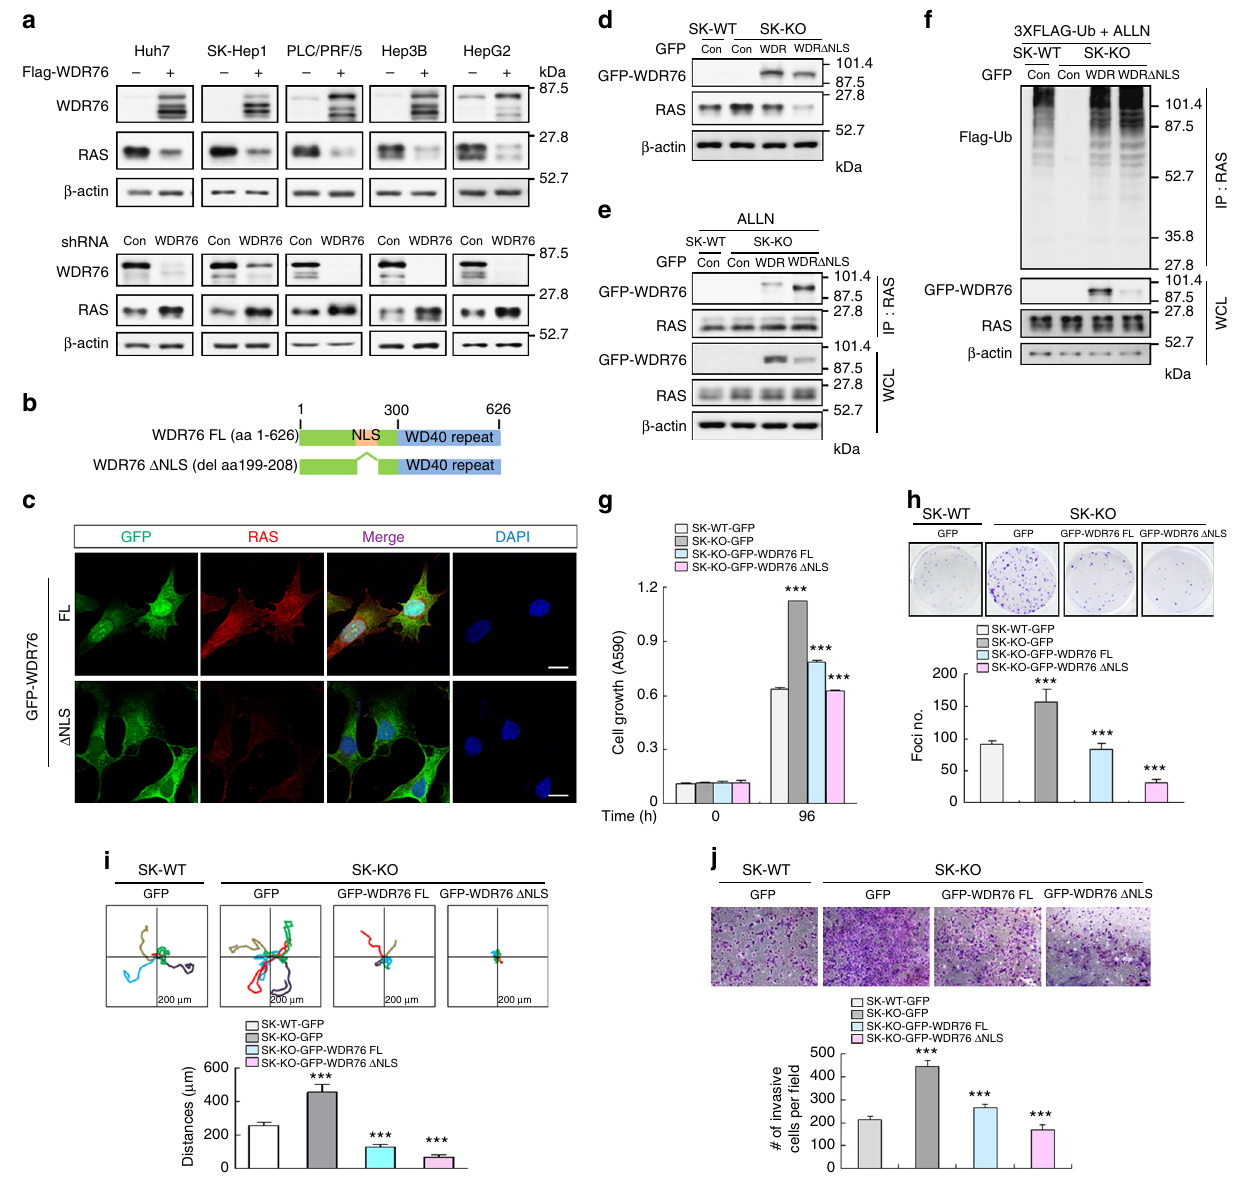
Fig. 3 WDR76 suppresses proliferation, transformation, motility and invasive properties of liver cancer cells through RAS destabilization. a IBs of RAS in Flag-WDR76 or shWDR76 -transfected Huh7, SK-Hep1, PLC/PRF/5, Hep3B, and HepG2 cells. b Schematic representation of WDR76 and its NLS deleted forms. c SK-Hep1 cells stably expressing GFP-WDR76FL or GFP-WDR76 Δ NLS were analyzed. Immunocytochemical analyses data showing localizations of RAS and WDR76 were obtained by using the anti-RAS (red) or anti-GFP (green) antibody. The nuclei were stained with DAPI (blue). Scale bars, 20 µ m. d – f SK-WT cells stably expressing GFP, or SK-KO cells stably expressing GFP, GFP-WDR76FL, or GFP-WDR76 Δ NLS were analyzed ( d ), or were transfected with 3XFlag-Ub ( f ) and then treated with ALLN ( e , f ). WCLs were immunoprecipitated with antibody recognizing RAS ( e , f ). g , h Cells were cultured and MTT assay ( g ), and foci formation assays ( h ) were performed. Data are presented as the mean ± SD ( n = 3 biological replicates). Two-sided Student ’ s t test, *** p < 0.001. i Single-cell migratory behavior was monitored using real-time imaging microscopy at least fi ve independent times. Data are presented as the mean ± SD. j Invaded cells through the Matrigel were stained with crystal violet. Representative images were captured, and the total numbers of invaded cells were counted (bottom). Data are presented as the mean ± SD ( n = 3 biological replicates). Two-sided Student ’ s t test, *** p < 0.001. Scale